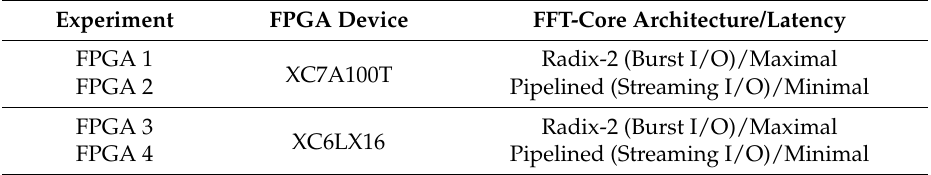
Table 1. Field programmable gate arrays (FPGAs) experiments.